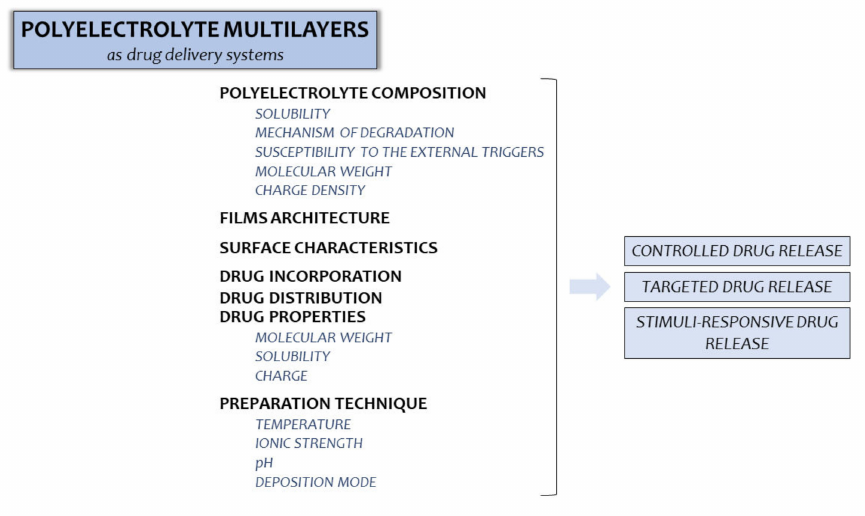
Figure 3. Factors which should be taken into consideration in PEMs designing as potential drug delivery